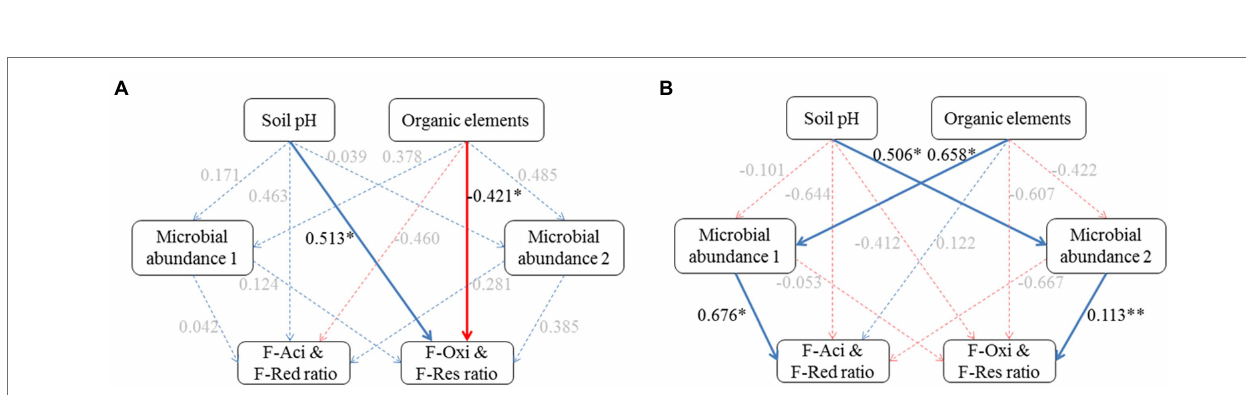
FIGURE 4 | Distinct relationships between the soil microbial community and Cd speciation ratios in the plow layer and plow pan soils. (A) Redundancy analysis. (B) Variation partitioning analysis. (C) Pearson correlation analysis. (D) Sub-network analysis. F-Aci, F-Red, F-Oxi, and F-Res indicate the acid-soluble fraction, reducible fraction, oxidizable fraction, and residual fraction of Cd, respectively. Venn diagrams represent the OTU numbers related with the Cd speciation ratio between the plow layer soils (blue) and plow pan soils (yellow).